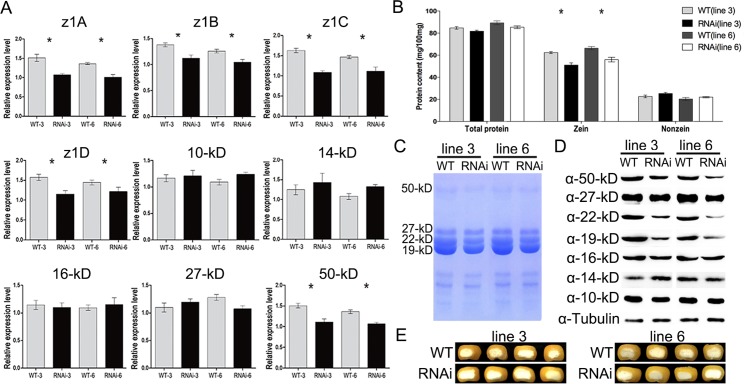
Zein content in ZmMADS47 RNAi transgenic lines.A. Real-time PCR assay to detect zein transcripts in RNAi lines 3 and 6 in. ZmUBQ was used as an internal control. All the assays were repeated three times. Error bars represent SD (n = 3) (*P < 0.05, Student’s t test). B. Comparison of zein, nonzein, and total proteins from wild type and RNAi lines 3 and 6 mature endosperm. The measurements were done on per mg of dried endosperm. Error bars represent SD (n = 3) (*P < 0.05, Student’s t test). C. SDS-PAGE detection of zein accumulation in RNAi lines 3 and 6. D. Immunoblot detection of zein proteins in RNAi lines 3and 6 with specific zein antibodies. E. Cross section of segregating wild type and RNAi mutant kernels from ears of lines 3 and 6 at maturity.